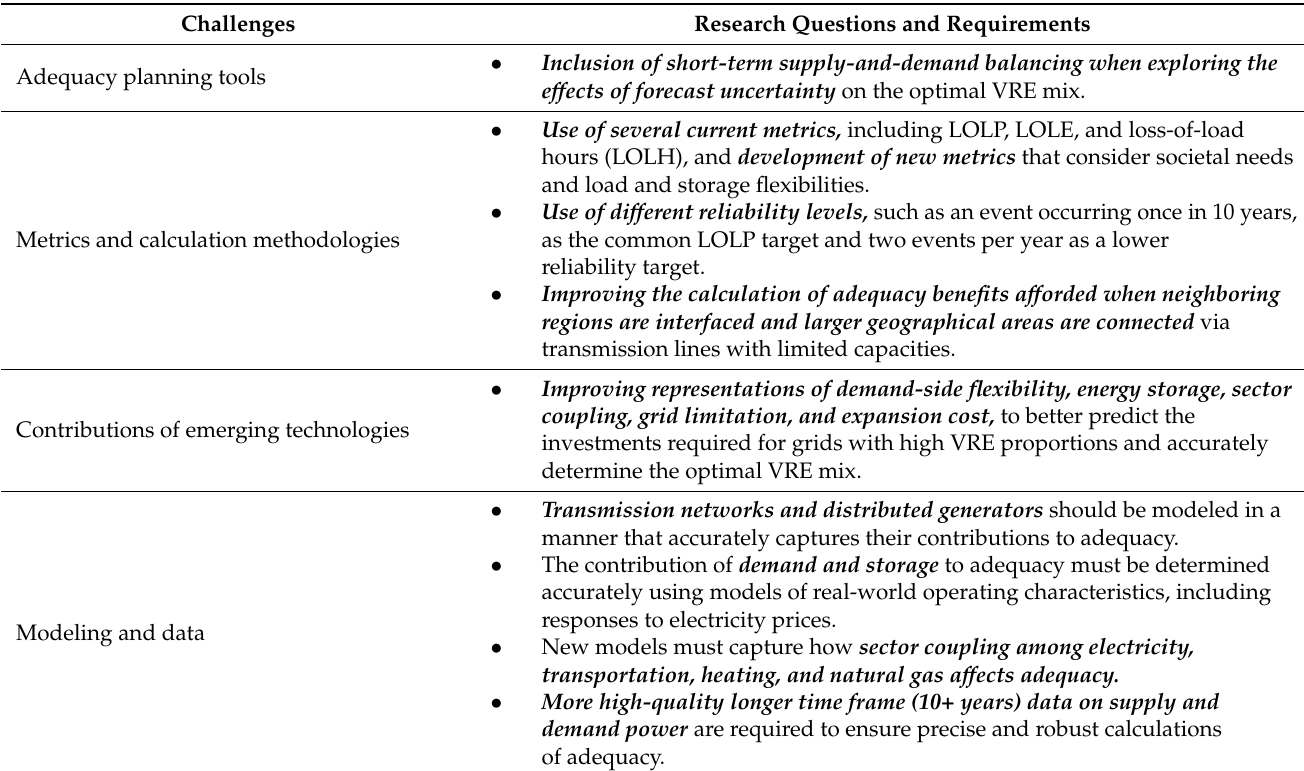
Table 14. List of research challenges in energy and capacity